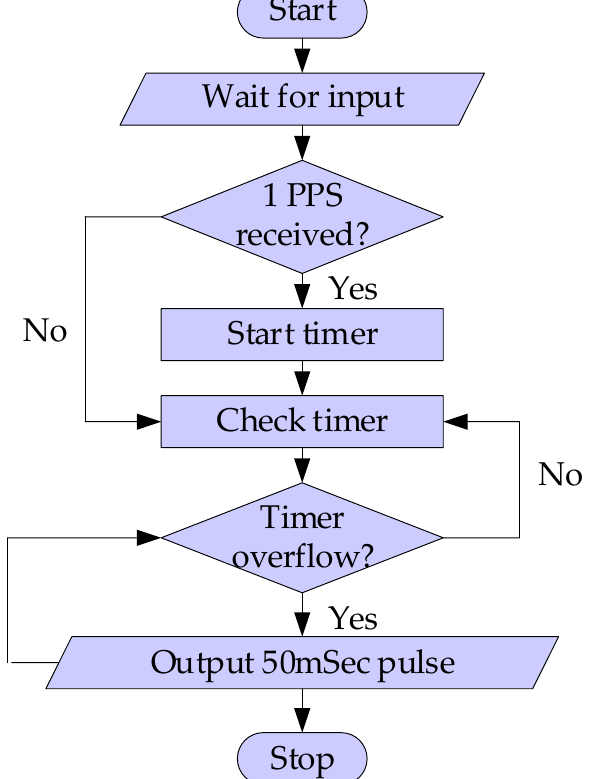
Figure 20. Simplified flowchart of the programmed GPSDO in the proposed PMU.